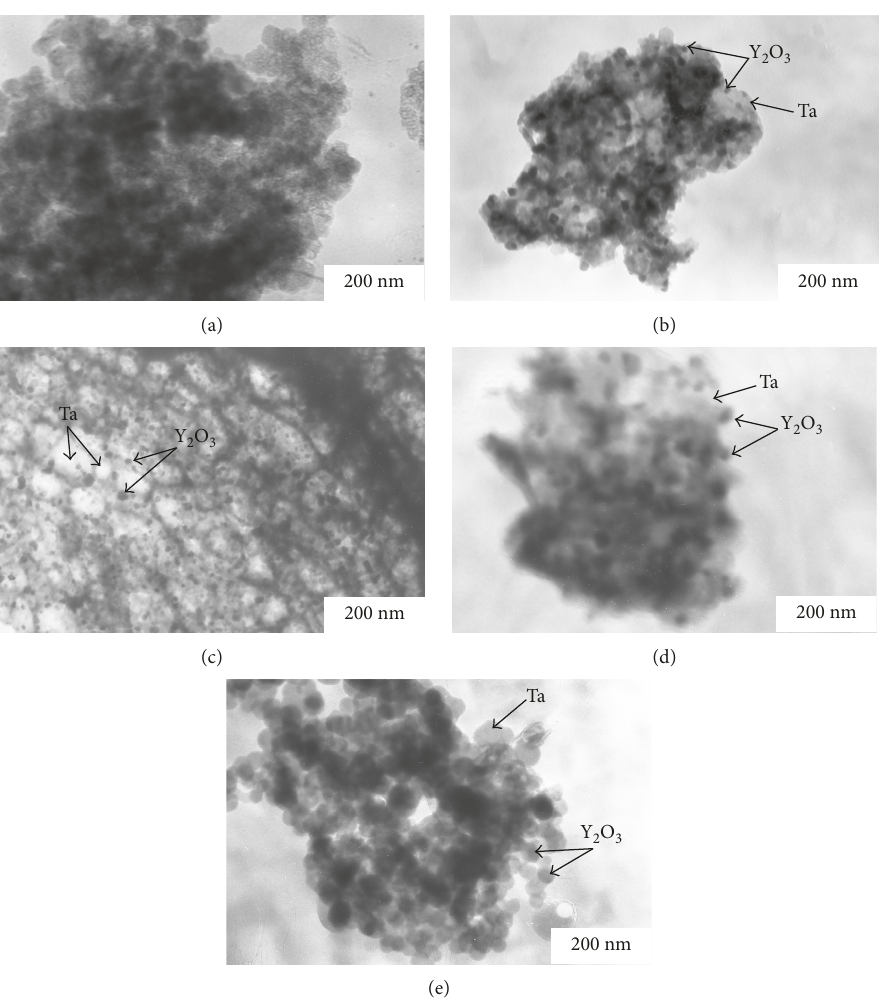
2 O 3 (b), Ta-10Y 2 O 3 (c), Ta-20Y 2 O 3